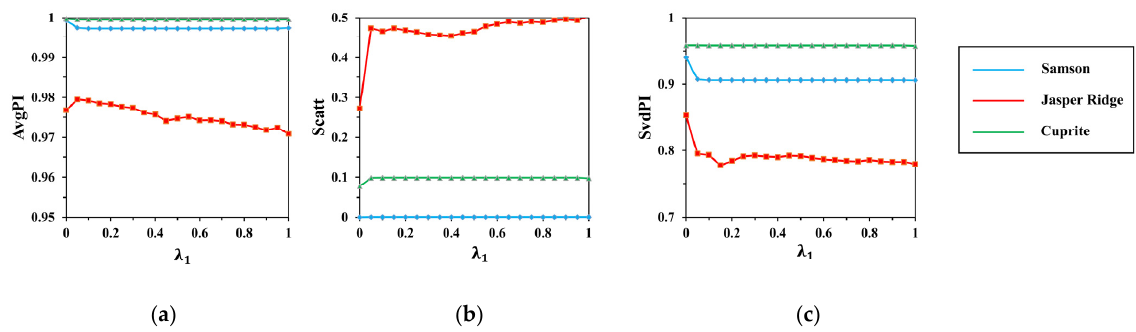
Figure 6. The results of ( a ) Scatt; ( b ) AvgPI; ( c ) SvdPI with the change of λ 1 .